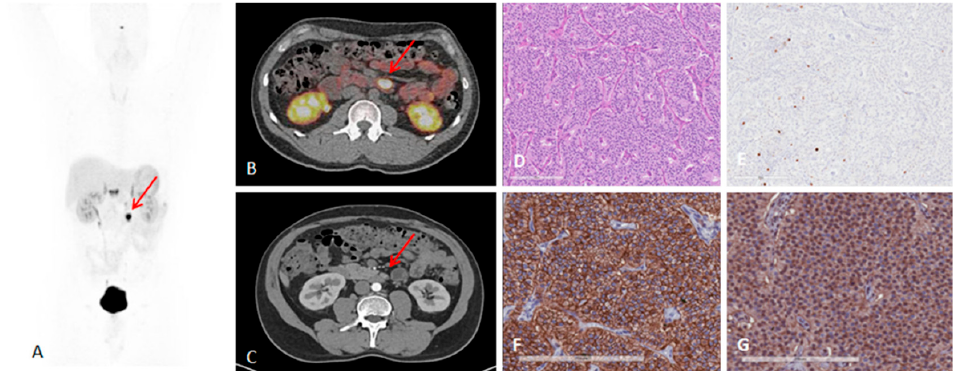
Figure 4. A 41-year-old man with metastatic lymph nodes on [ 68 Ga]Ga-DOTA-TATE PET / CT. He had undergone previous surgery for pancreatic NET (patient 5). Mesenteric lymph node from primary pancreatic NET was found with probe with TBR of 3.4 for this 0.8 cm lesion (WHO grade 1). ( A ) [ 68 Ga]Ga-DOTA-TATE PET maximum intensity projection image showing mesenteric / duodenal lesion in segment 3 (red arrow) and multiple retroperitoneal lymph nodes. ( B ) [ 68 Ga]Ga-DOTA-TATE PET / CT image showing mesenteric mass with SUVmax of 72.8 (red arrow). ( C ) Arterial phase CT showing corresponding mesenteric mass (red arrow). ( D ) Representative hematoxylin and eosin staining of tumor showing NET in lymph node, WHO grade 1. ( E ) Representative immunohistochemistry for MIB-1 staining showing <2% of cells positive. ( F ) Immunohistochemistry for SSTR2 showing representative image for score 3 (membranous pattern of SSTR2 staining in >50% of tumor cells) (original magnification, ×20). ( G ) Immunohistochemistry for SSTR5 showing representative image of tumor with > 10% of tumor cells positive (original magnification, × 20). Reproduced from